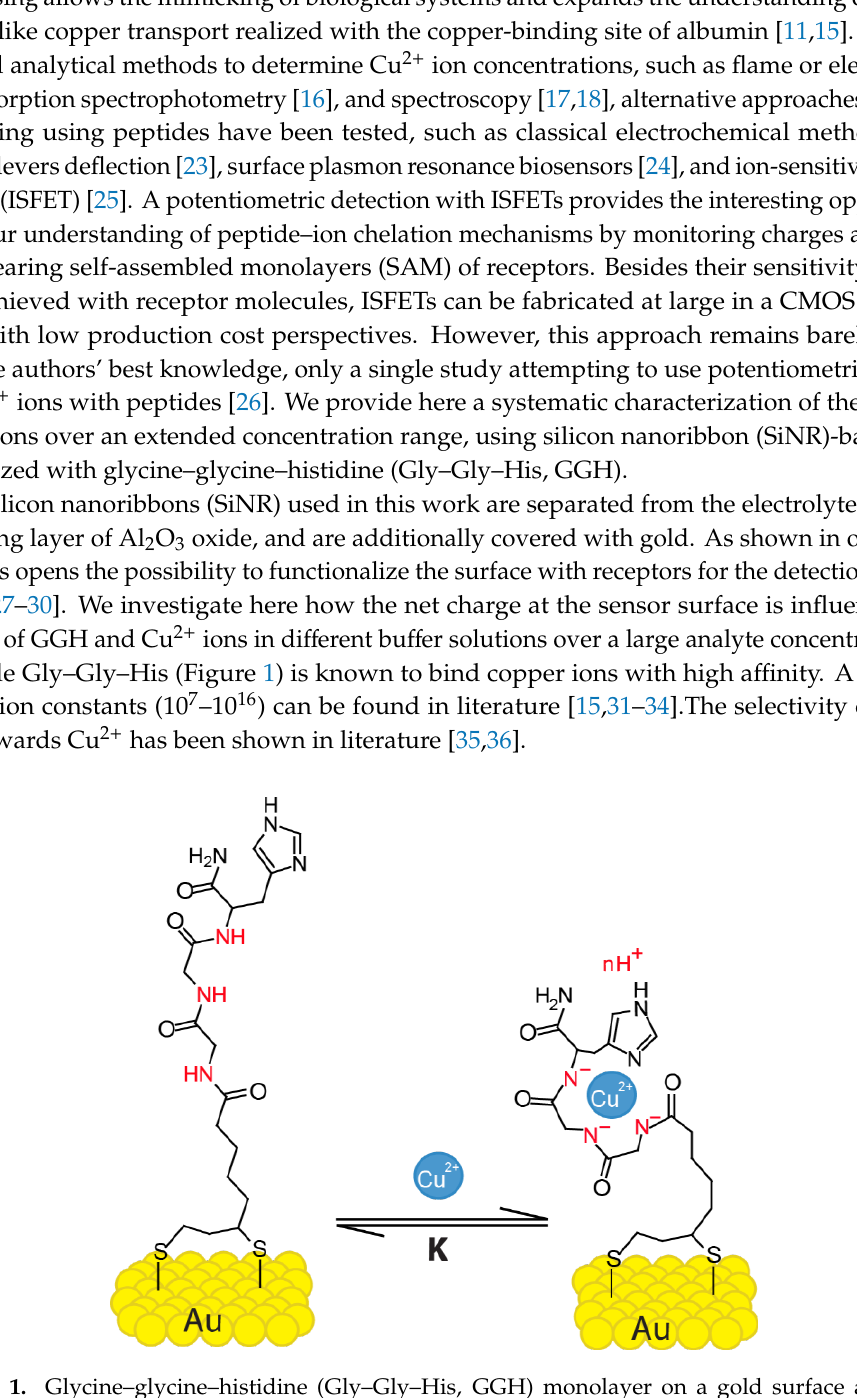
Figure 1. Glycine–glycine–histidine (Gly–Gly–His, GGH) monolayer on a gold surface and the complexation of Cu 2+ ions. Secondary amines, carrying different charges depending on the electrolyte’s pH, are indicated in red.